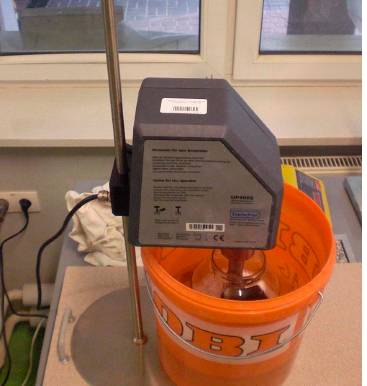
Figure 2. Laboratory stand for the production of the CNT suspension.